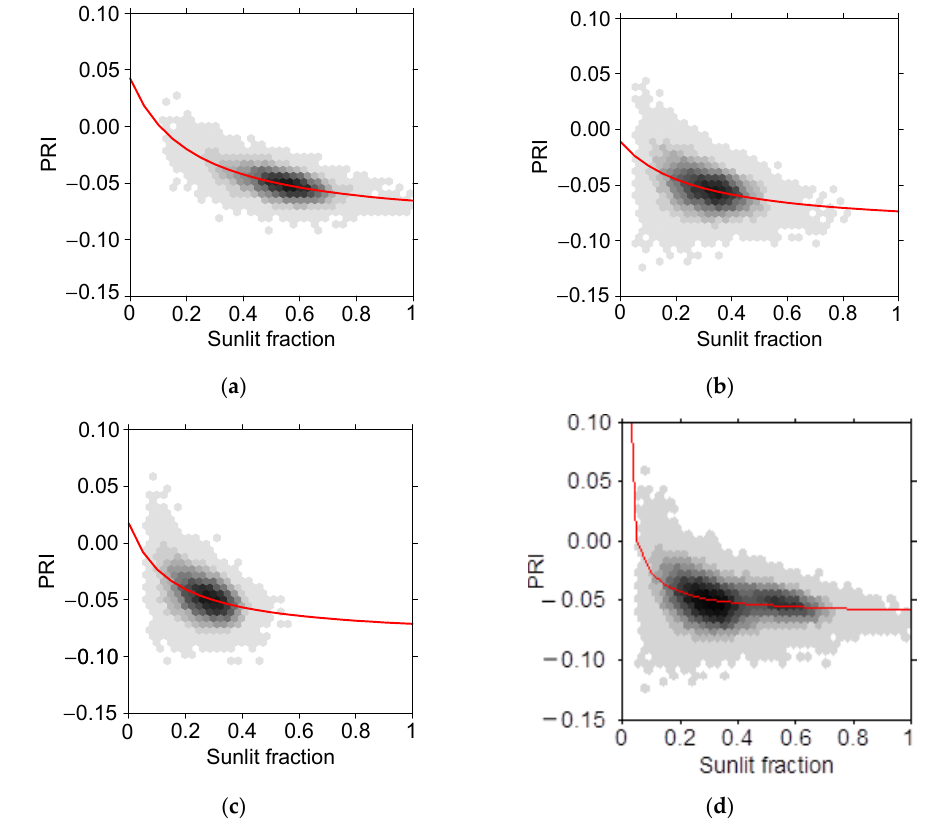
Figure 10. Non-linear fit of PRI as a function of the sunlit fraction α S for β = 19 ◦ ( a ); β = 55 ◦ ( b ); β = 76 ◦ ( c ); and all data ( d ). Lines are least squares fits of Equation